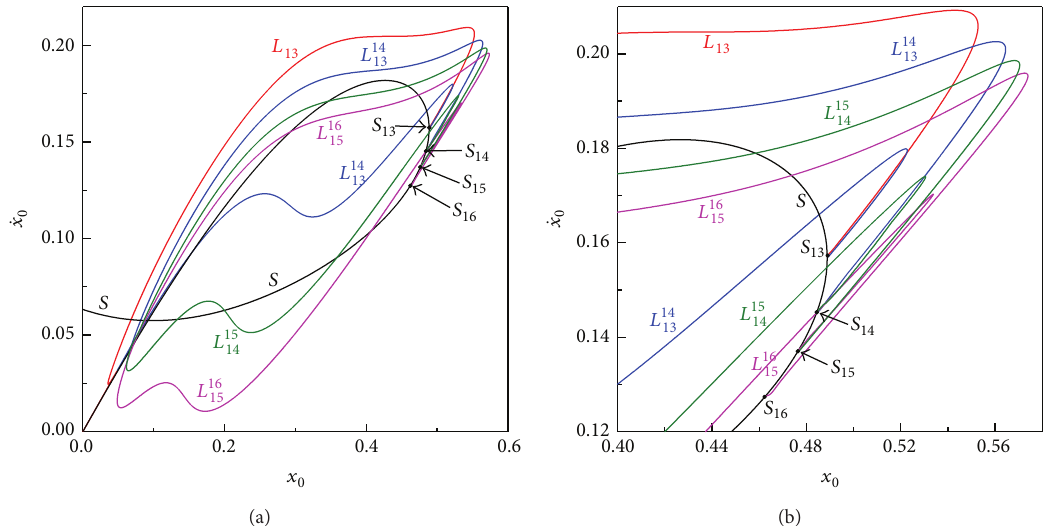
Figure 10: (a) Projection of the characteristic curve of the long period family in the (𝑥 0 , ̇𝑥 0 ) plane. (b) Magnification of part of the left frame. In both frames, 𝑆 denotes the short period family.